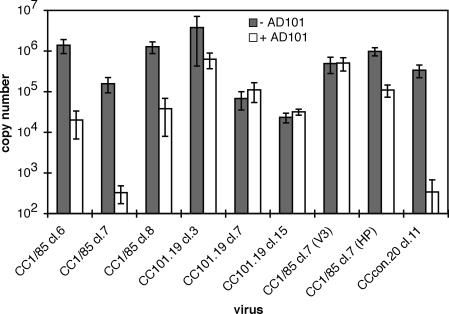
Replication of Clonal, Env-Chimeric Viruses in Singly Infected CulturesThe extent of replication is shown as the mean copy number per QPCR reaction ± SEM from three to 47 independent, singly infected cultures. AD101 was absent (shaded bars) or was present at 1 μM (open bars). The initial MOI was 0.0005.